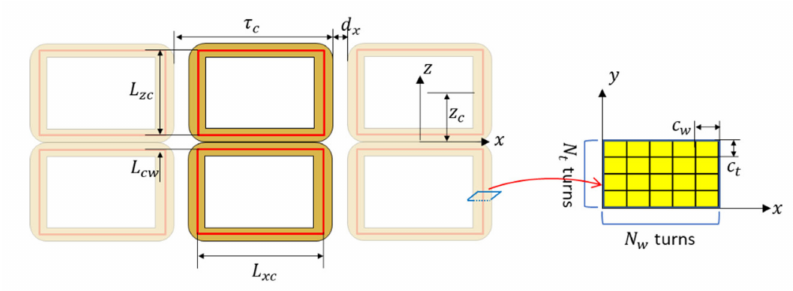
Figure 11. Design parameters of null-flux levitation coils arranged on both sides of the guideway. The levitation and guidance performance at the maximum vertical displacement point P z = ( 0, − ∆ z max ) and maximum horizontal displacement P y = ( − ∆ y max , − ∆ z max /2 ) were